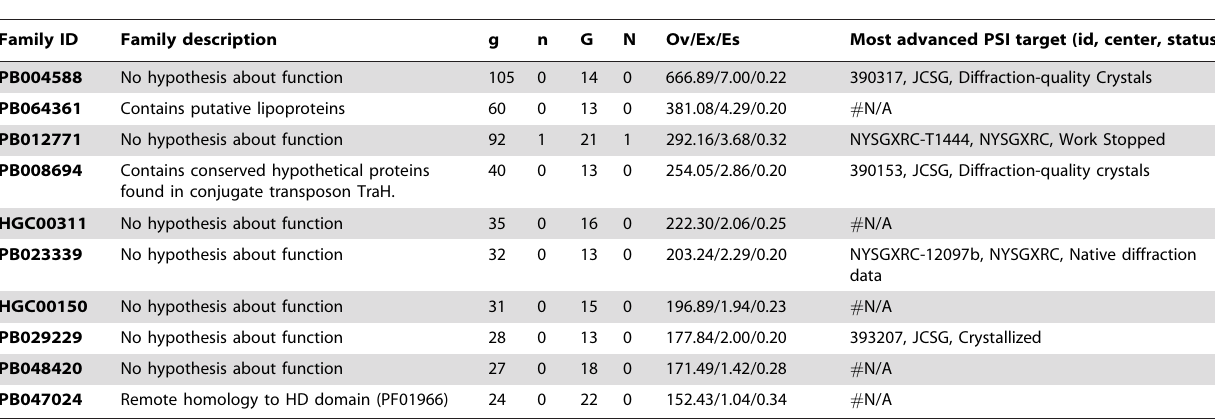
Table 4. 10 top most overrepresented (Ov) new families, from the set of over 180 curated novel families identified in this work.